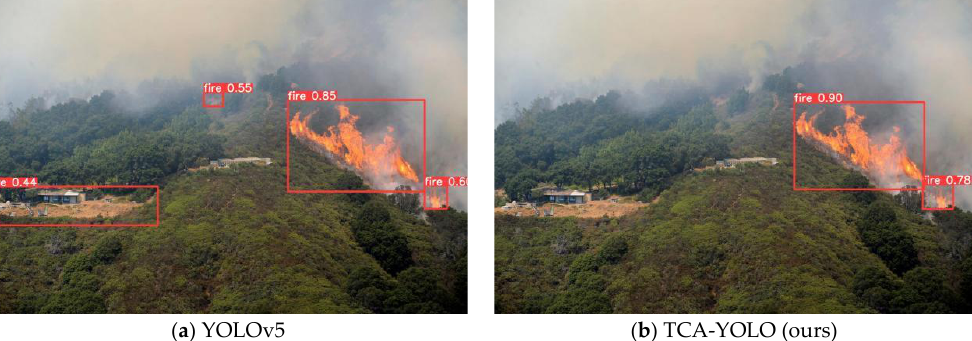
Figure 10. Comparison of anti-interference capability. ( a ) Two targets were misdetected by YOLOv5. ( b ) Our model has no misdetected targets. As shown in Figure 11, YOLOv5 fails to effectively extract the global information of the forest fire target in the figure; only the local area of the forest fire target is framed. It cannot effectively localize the forest fire target. In contrast. TCA-YOLO can effectively extract the global information of the forest fire target, and the receptive field is much larger.